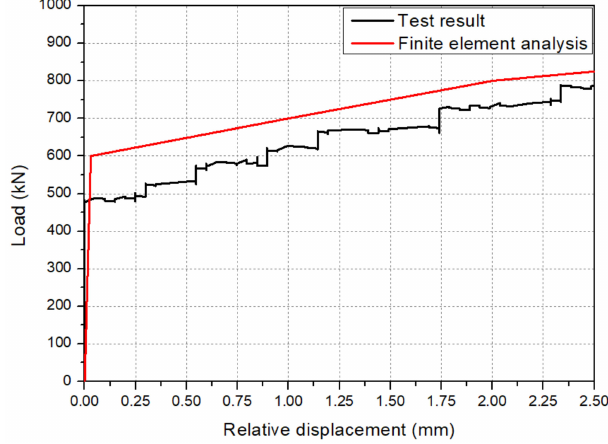
Figure 14. Comparison of load–relative displacement curves from the test and FEM analysis results of